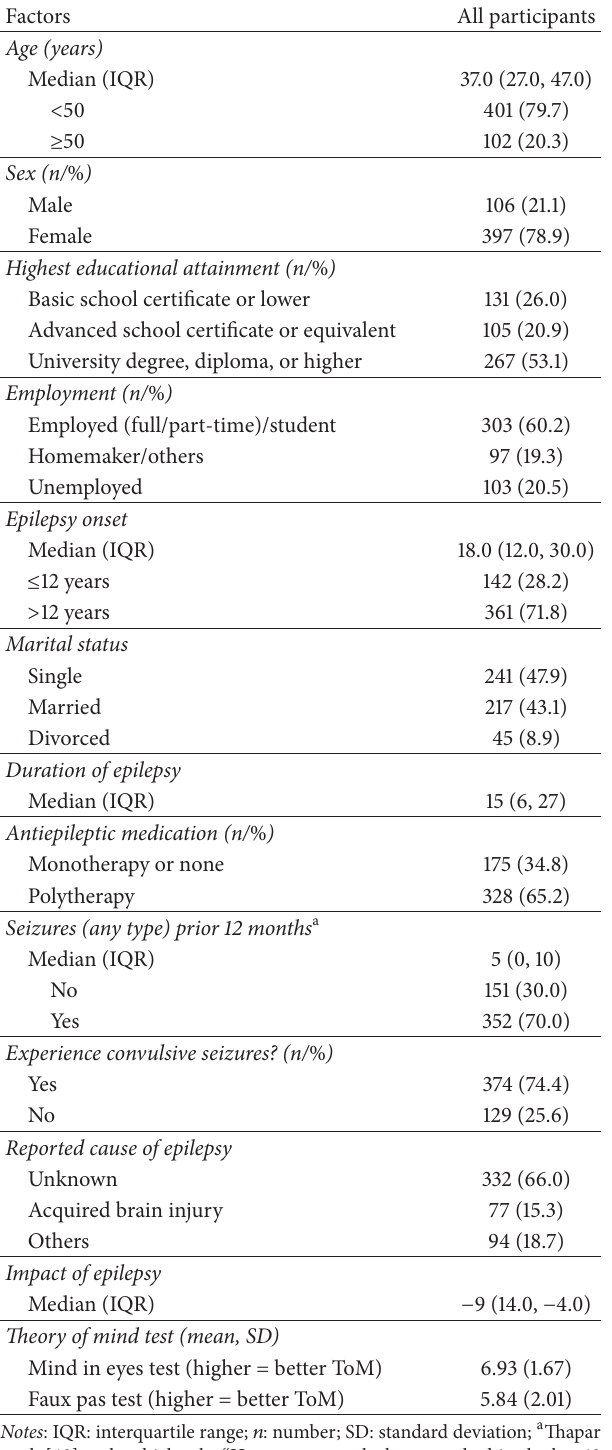
Table 1: Clinical and demographic characteristics of